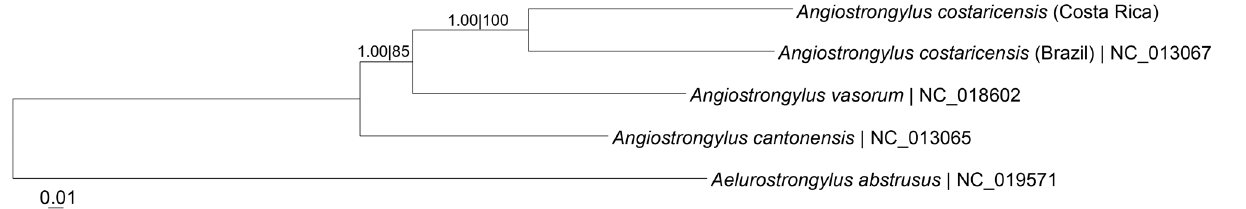
Fig 3. Bayesian inference and maximum likelihood tree based on 12 protein-coding genes of the whole mitogenomes of Angiostrongylus costaricensis and congeners with Aelurostrongylus abstrusus as outgroup. Numeric values at the nodes are Bayesian posterior probabilities/ML bootstrap.